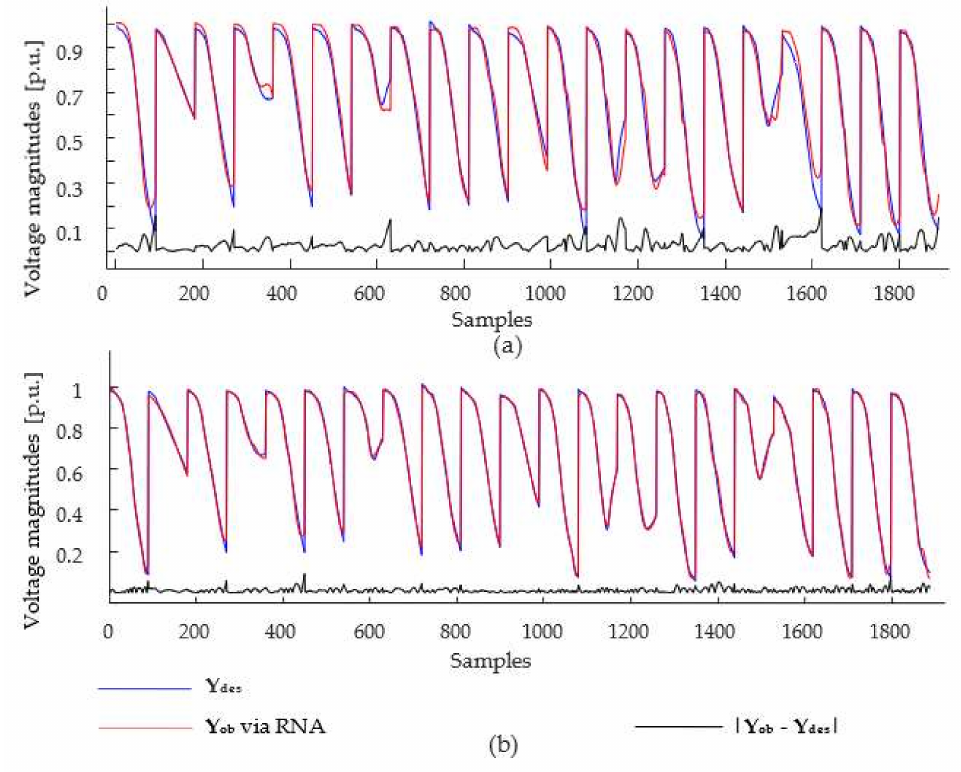
Figure 6. Voltage magnitudes of load bus 14 for all samples (1890), i.e., for all system contingencies, desired output ( Y des ) vs. output obtained ( Y ob ) via RNA in training; ( a ) MLP, ( b )